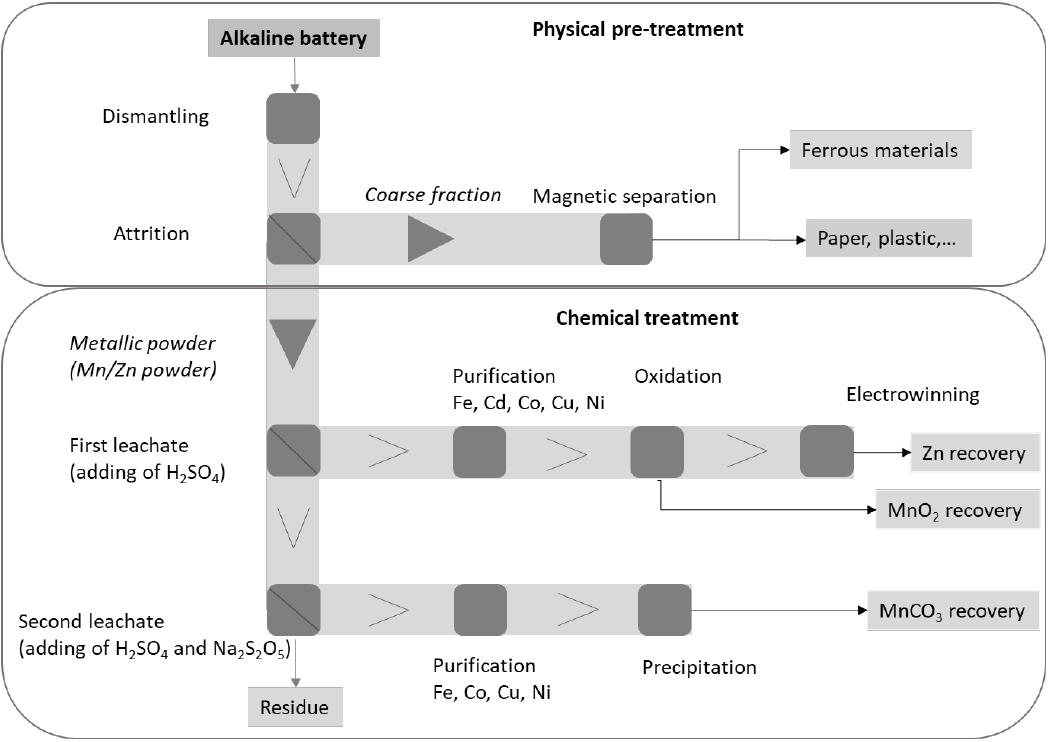
Figure 1. Detailed flow sheet of the hydrometallurgical route to treat the spent alkaline batteries.